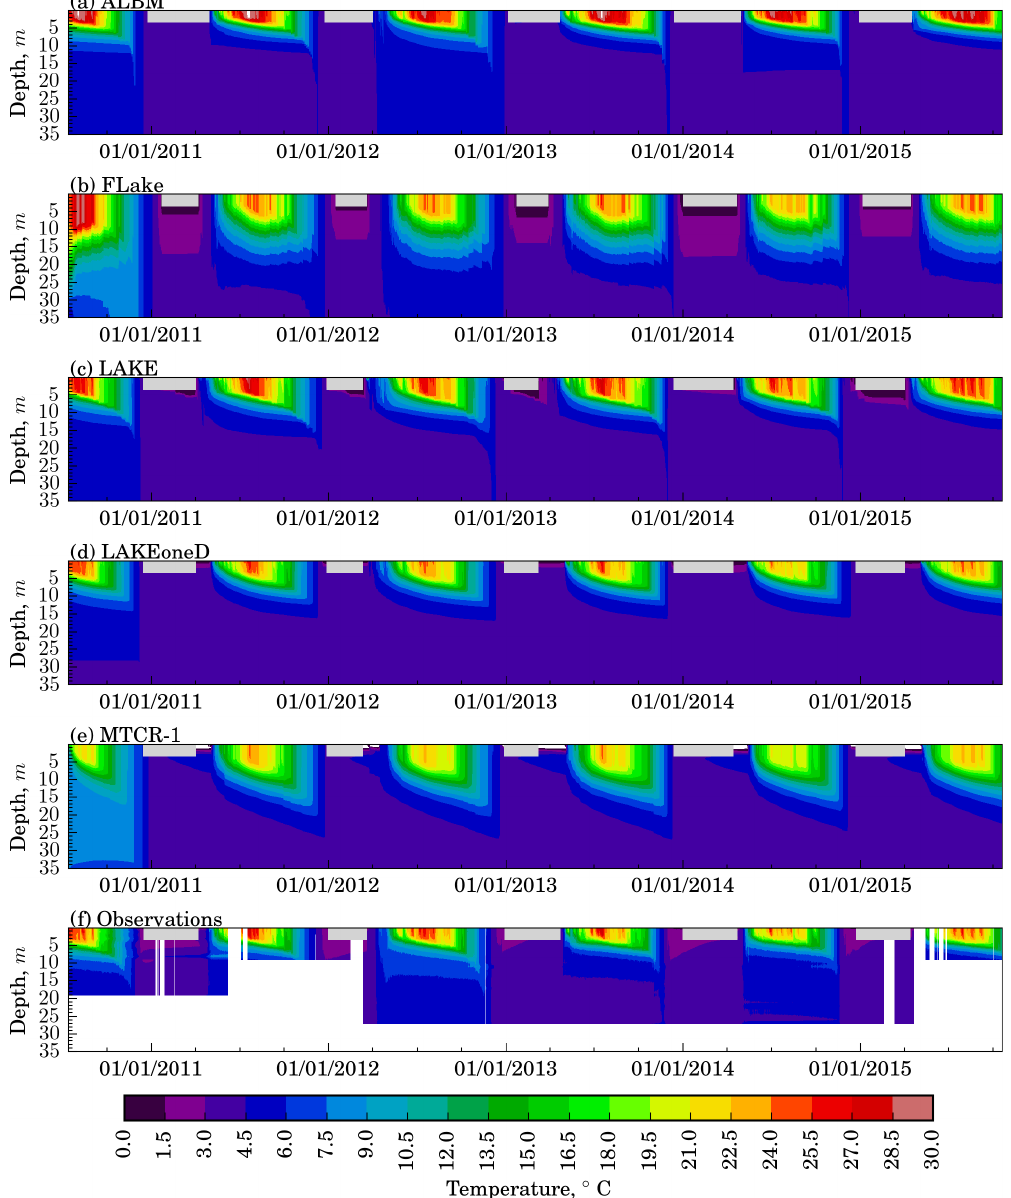
Figure 2. Time–depth pattern of temperature in Harp Lake (14 July 2010–19 October 2015), RefSim and observed data. The grey boxes represent the duration of the ice-cover period, and the white patterns denote the absence of